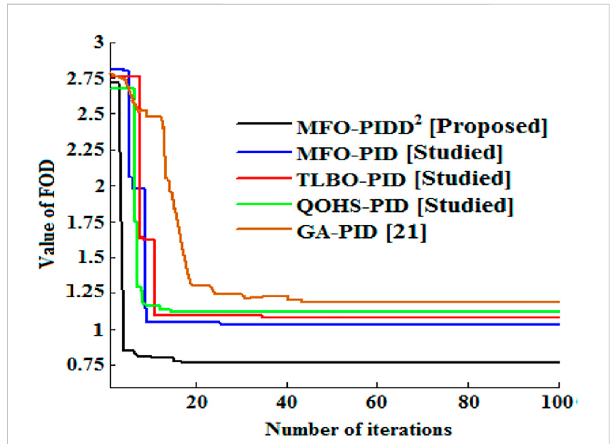
FIGURE 7 Comparison of convergence pro fi les for the studied APS with K G (cid:2) 1 . 0 and τ G (cid:2) 1 . 0